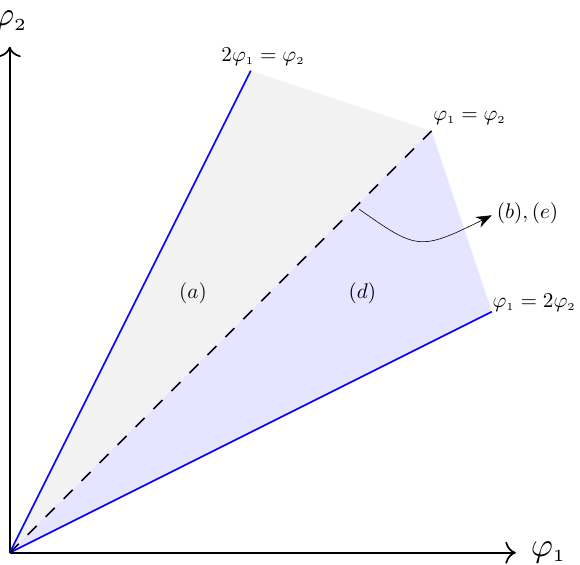
Figure 25: The Coulomb branch of the rank-two beetle SCFT is shown in the shaded area. It consists of two chambers, corresponding to resolutions (a) and (d). The middle wall corresponds to a degeneration of both resolutions (b) and